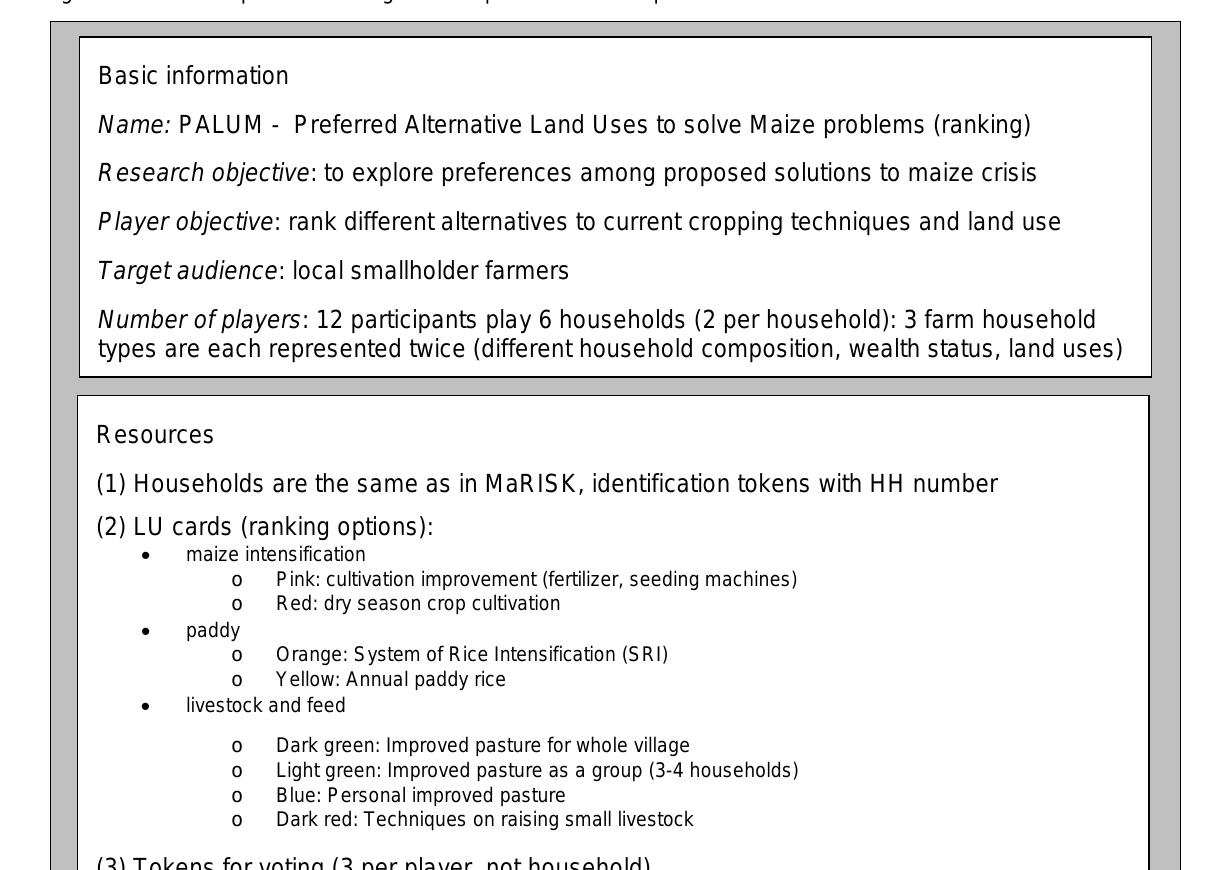
Figure A.2.4. Description of ranking workshop PALUM developed in